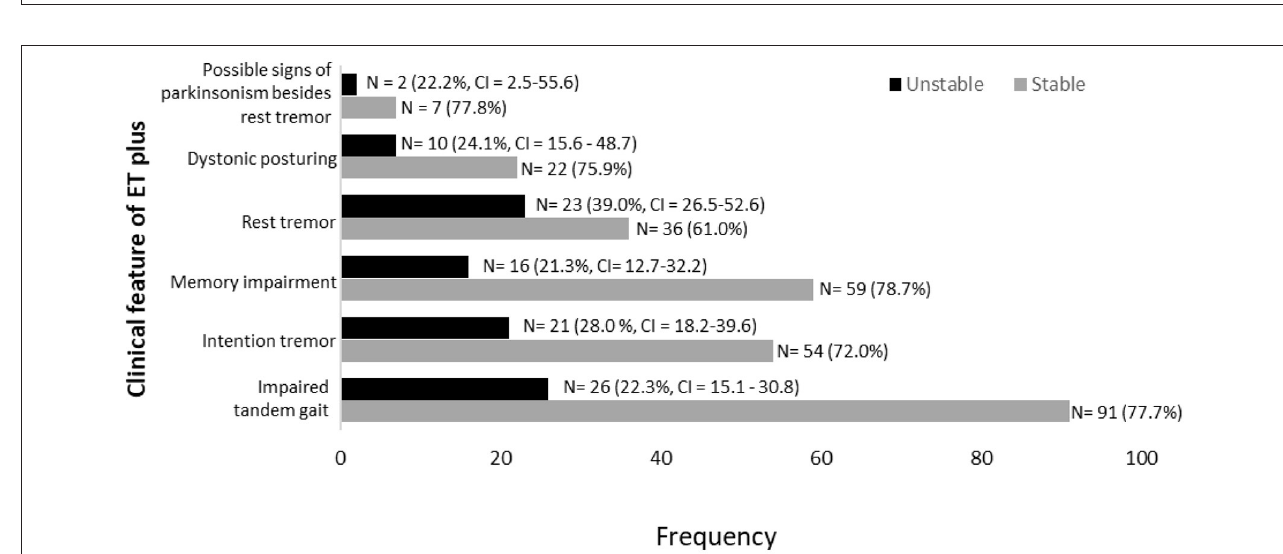
FIGURE 4 | Distribution of types of ET vs. ET plus diagnoses in 201 participants.